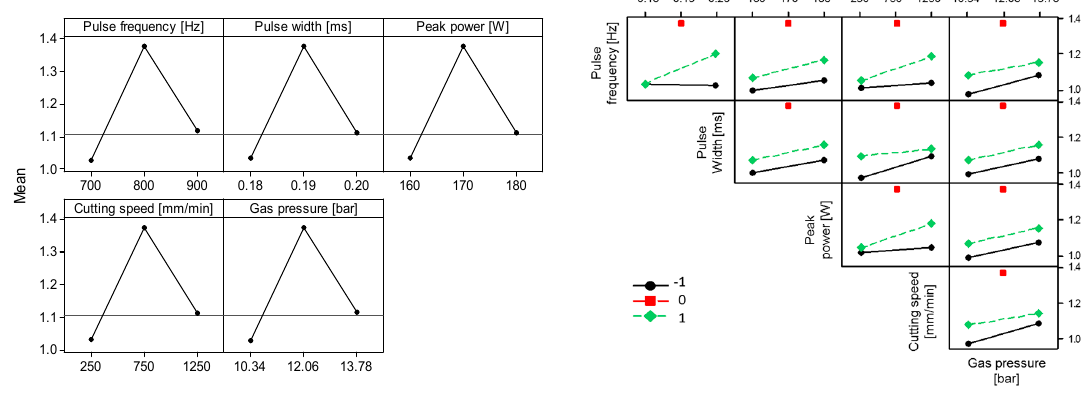
Figure 3. Main effects and interaction plots for surface roughness (miniature tube type A).